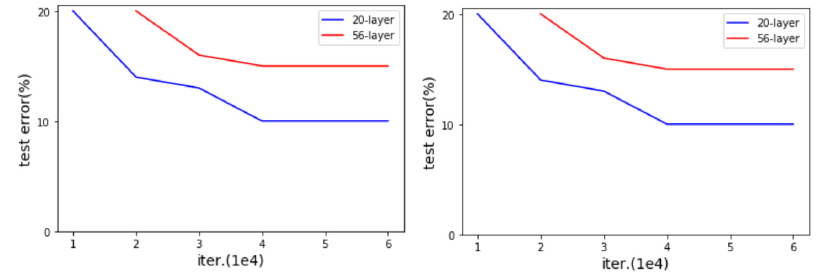
Figure 5. Results of a performance experiment based on network layer change [12,17].